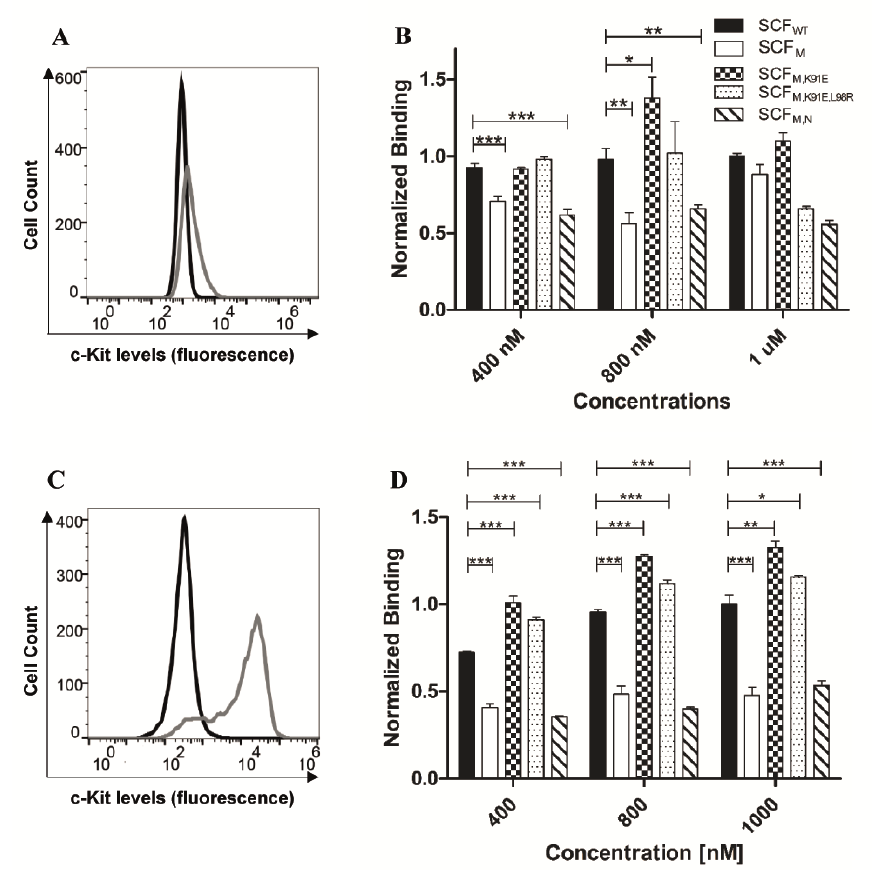
Figure 4. Improved and reduced binding of SCF variants to cell-surface c-Kit. ( A ) Expression levels of c-Kit in the A172 cell line. Grey and black lines represent c-Kit expression and background signals, respectively. ( B ) Binding of SCF variants to A172 cells expressing c-Kit. ( C ) Expression levels of c-Kit in murine HSPCs. ( D ) Binding of SCF variants to HSPCs. In panels ( B , D ) the columns are designated as follows: SCF WT (black columns), SCF M (white columns) and SCF M,K91E (checkered columns),